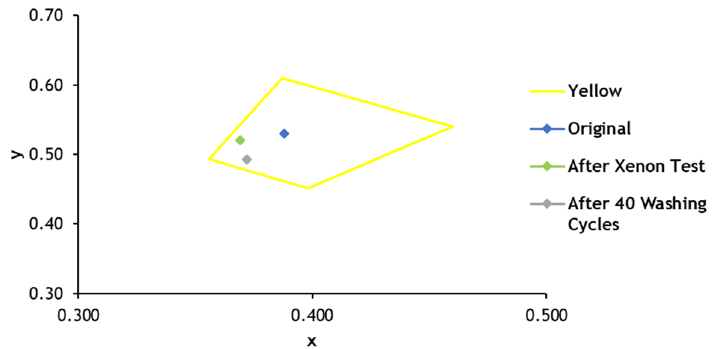
Figure 5. Chromaticity coordinates obtained for industrial coated sample with 15% YE 517 pigment.